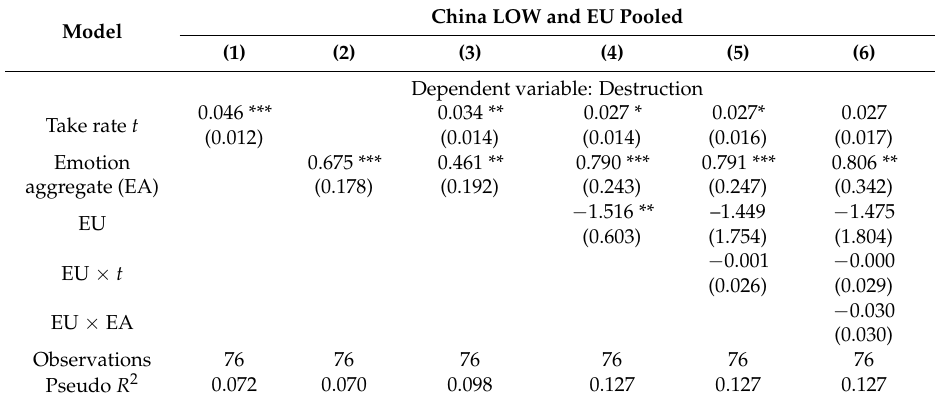
Table 6. China LOW and EU: Impact of take rate and emotions on destruction (pooled